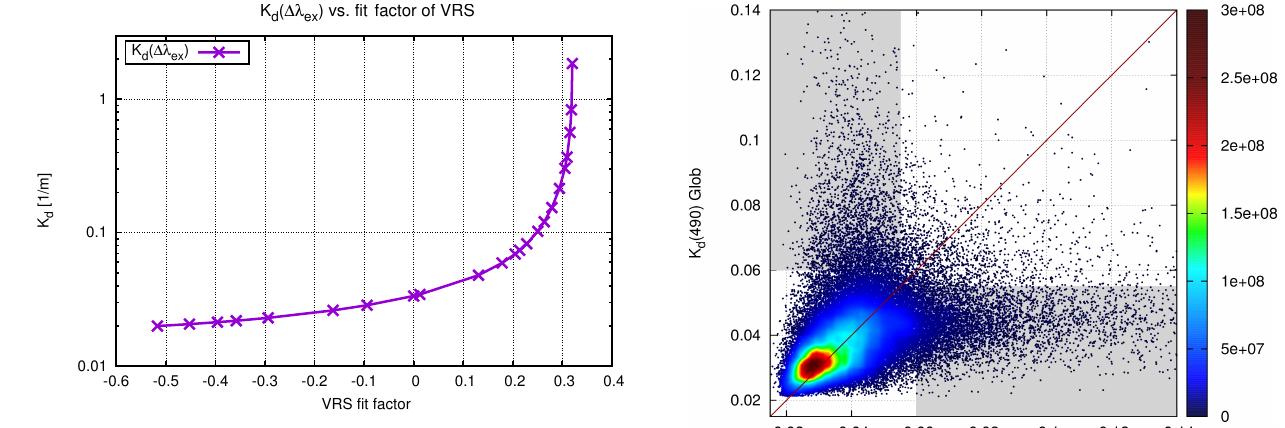
Figure 14. Resulting relationship of the VRS fit factor with the dif- fuse attenuation coefficient for a SZA of 40 ◦ , which is used as a LUT for the retrieval of K d ((cid:49)λ ex ) from SCIAMACHY satellite data.